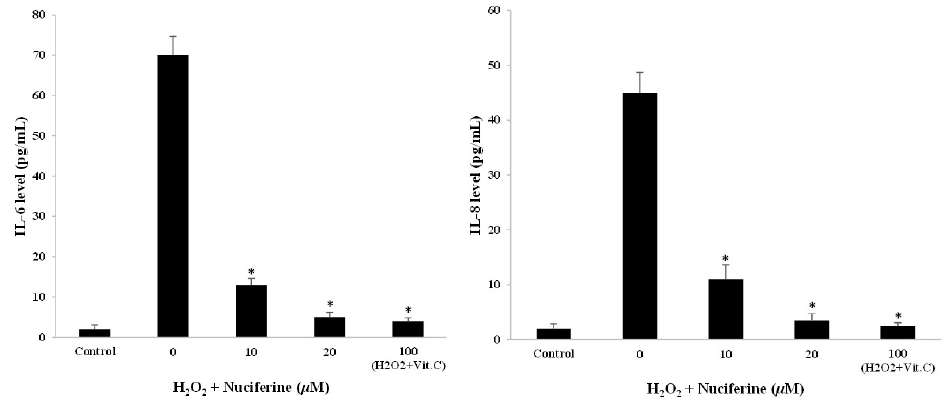
Figure 4. Effect of nuciferine on IL-6 and IL-8 secretion upon H 2 O 2 -induced fibroblast senescence. Cell-cultured media from non-treated and treated fibroblasts were aspirated and measured for IL-6 and IL-8 by ELISA technique. Mean ± SEM from triplicate independent experiments, * indicates p < 0.05 of one-way ANOVA.